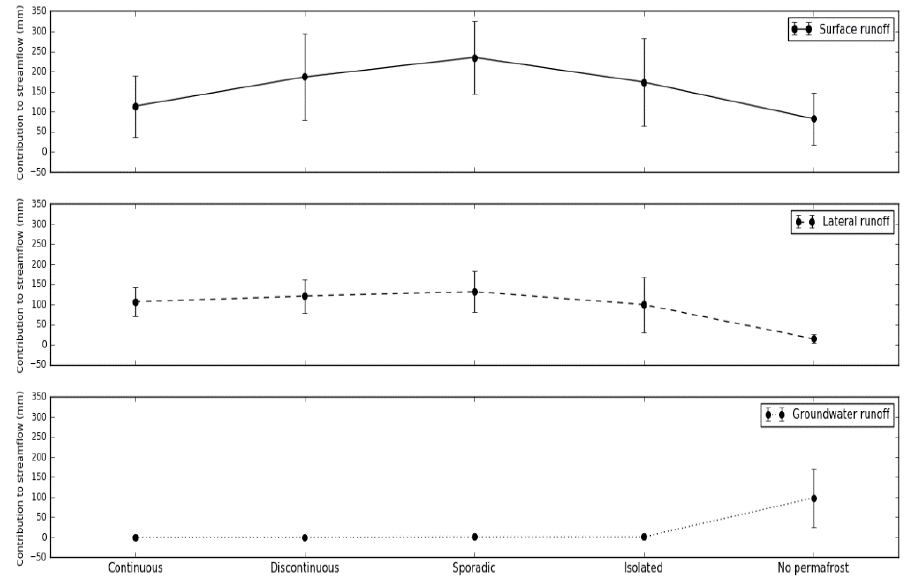
Figure 6. Average contribution to streamflow for each flow depending on the type of permafrost.